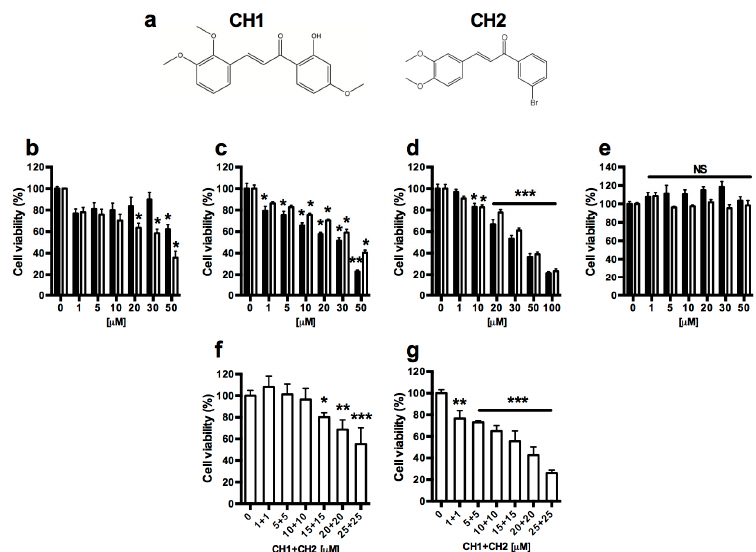
Figure 2. Effect of the chalcones CH1 and CH2 on the growth of human hepatocellular carcinoma (HepG2 and HuH-7) and normal mouse hepatocyte (HepM). Structures of CH1 and CH2 ( a ); HepG2 ( b , c ); HuH-7 ( d ) and HepM ( e ) were treated with various concentrations of the compounds CH1 (Black bars) and CH2 (White bars) for 24 ( b ) and 48 ( c – e ) h. Chalcones combined (CH1:CH2) were used in HepG2 ( f ) and HuH-7 ( g ) cells for 48 h. Cell viability was measured using the MTT assay. Data are expressed as the mean ± SEM from three independent experiments, each performed in triplicate. Statistical differences were assessed by a one-way ANOVA (Kruskal–Wallis) followed by Dunn’s post hoc test. * p < 0.05, ** p < 0.01, *** p < 0.001 compared with the condition 0 μ M, NS, Non-significant.